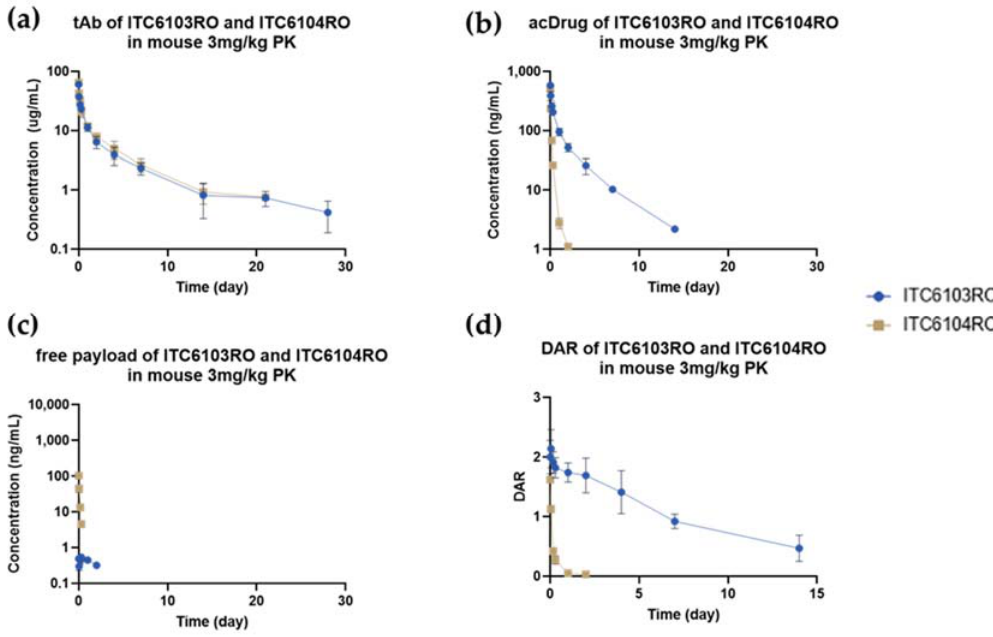
Figure 4. Pharmacokinetic (PK) profiles of ( a ) tAb, ( b ) acDrug, ( c ) free payload and the ( d ) calculated DAR profiles after intravenous administration of 3 mg/kg for ITC6103RO and ITC6104RO, respectively, in mice. Table 3. Pharmacokinetic parameters of tAb after intravenous administration of 3 mg/kg of ITC6103RO and ITC6104RO in mice. AUC last , Area under the curve up to last measurable concentration; CL, Clearance; α -HL, Alpha phase half-life; β -HL, Beta phase half-life; Cmax, Maximum plasma concentration; V 1 , Volume of distribution of central compartment, V ss , Volume of distrution at steady-state. Table 4. Pharmacokinetic parameters of acDrug after intravenous administration of 3 mg/kg of ITC6103RO and ITC6104RO in mice.